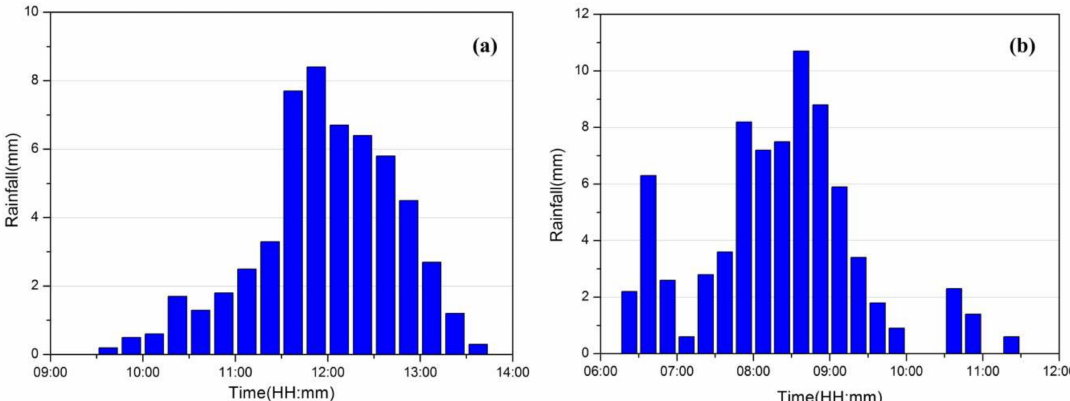
Figure 4. Rainfall records of the flood events that occurred on 20 June 2016 ( a ) and 1 July 2016 ( b ) at Wuhan